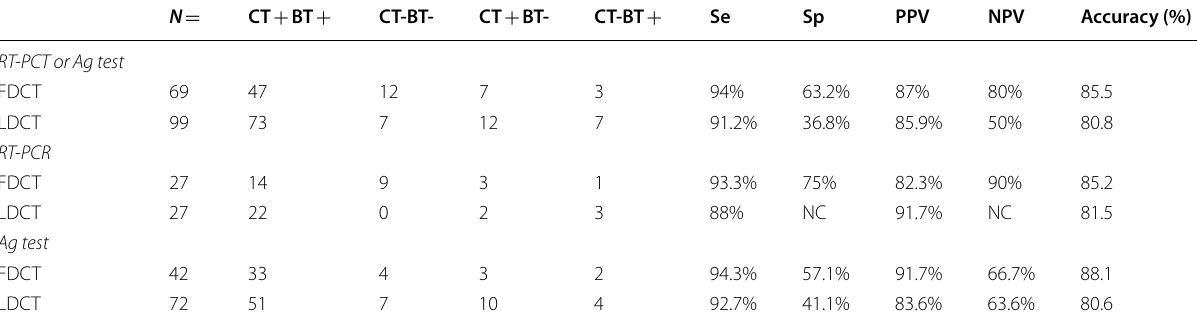
BT, Biological test; FDCT, full dose CT scan; LDCT, ultra-low dose CT scan; RT-PCR, reverse transcriptase polymerase chain reaction; Ag, Antigen; Se, Sensitivity; Sp, Specificity; PPV, Positive predictive value; NPV, Negative predictive value; NC, Not